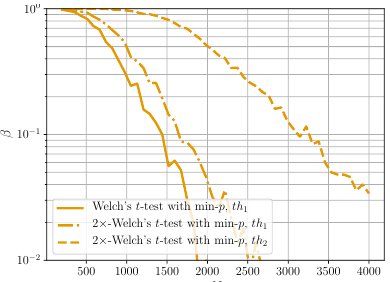
Figure 15: Detection rate of comparison with